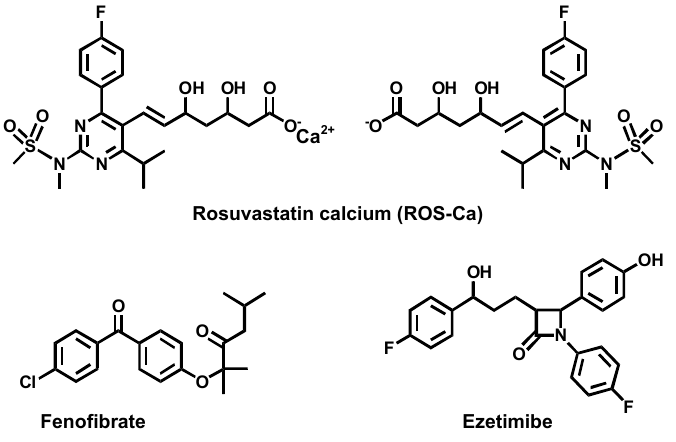
Figure 1. Chemical structures of rosuvastatin calcium (ROS-Ca) and the co-formulated drugs.